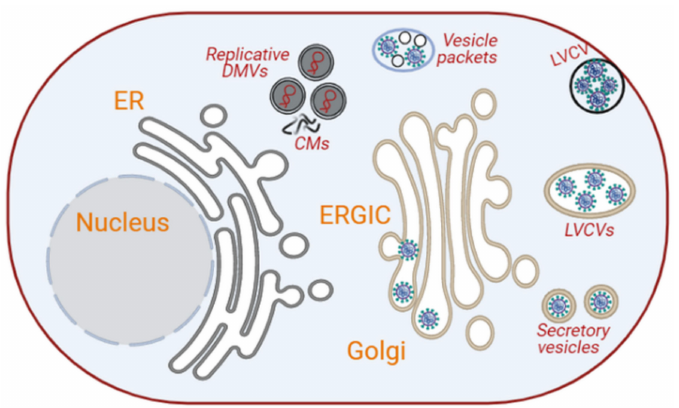
Figure 3. Intracellular membrane rearrangements induced by coronaviruses. Coronaviruses induce the formation of branched and unbranched ER vesicles, DMVs and CMs from the ER. The DMVs serve as platforms for replication/transcription. Initially, coronaviral particles assemble at the ERGIC/Golgi, which expand into LVCVs to accommodate more virion productions (image created in